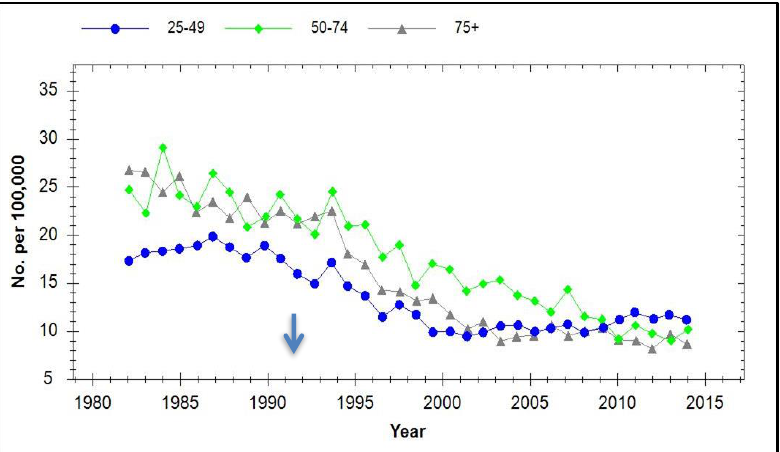
Figure 6. Age stratified incidence of cervical cancer in Australia from 1982 to 2015. Since the introduction of cervical screening in 1991, the incidence in the 25–49 years age range declined until 2001 then started to increase from 2009 until 2015. It is speculated that restructuring these results into the age groupings used for the UK data, as shown in Figure 5B, may prove informative.